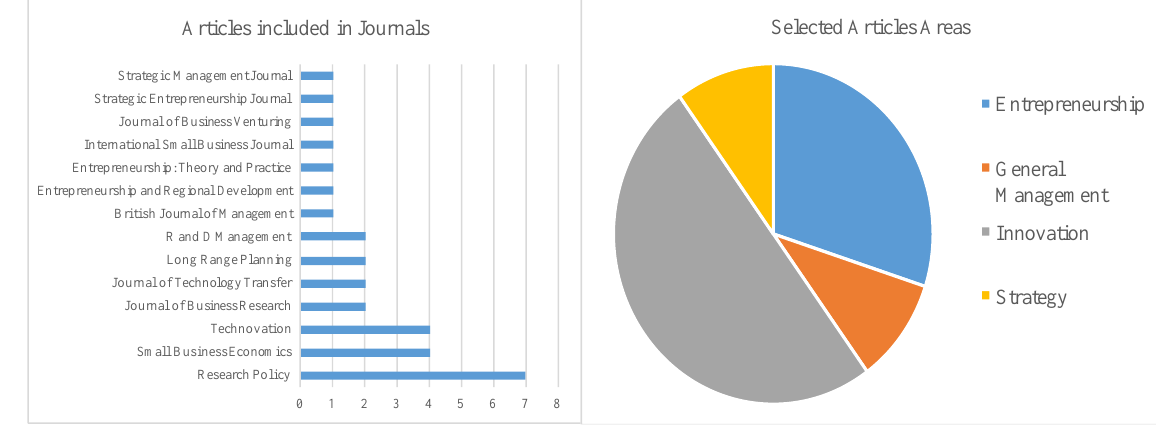
Fig. 2 : Journals and areas of selected